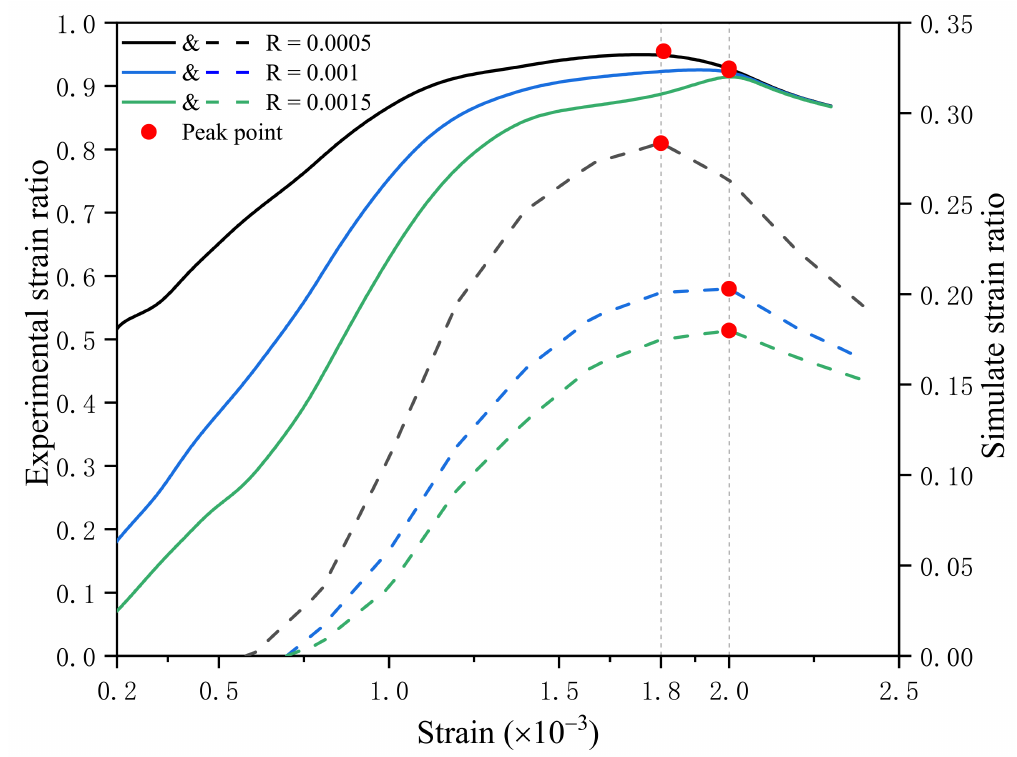
Figure 13. Strain ratio curves of different strain reference